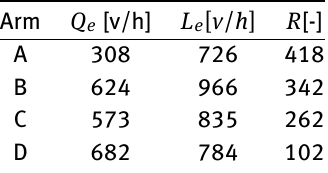
Table 5: Reserve of capacity of the entrances. Source: authors.